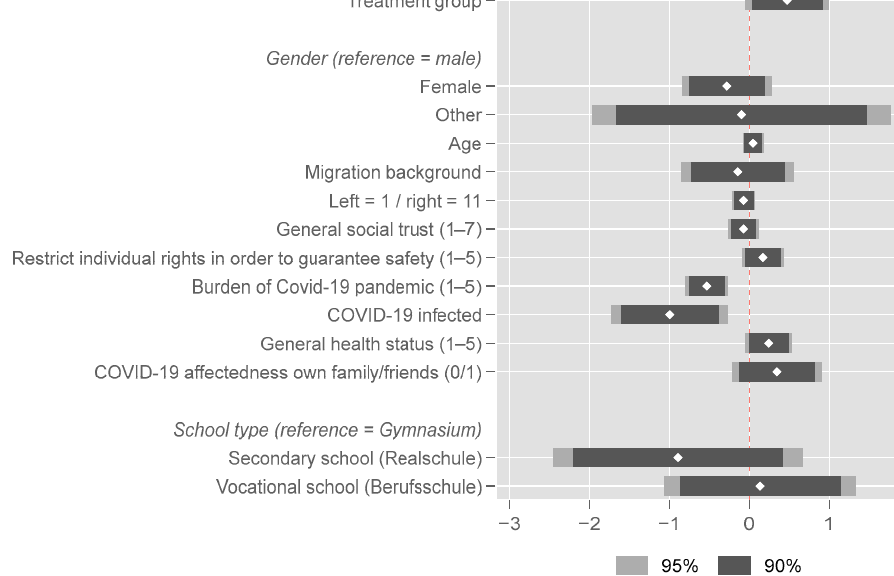
Figure 5. Approval of alternating online and in-classroom teaching, shown through OLS regression (b-coefficients + confidence intervals).